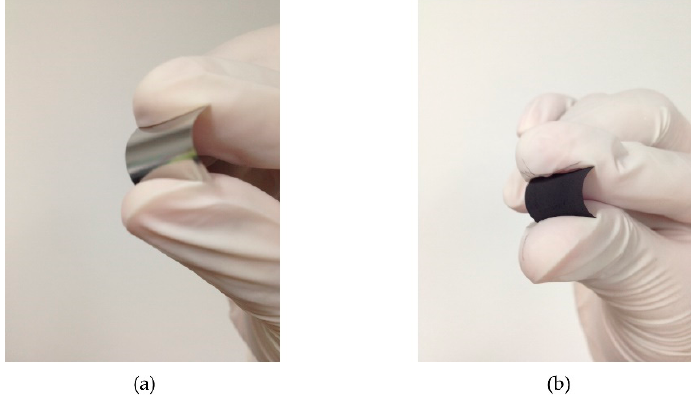
Figure 3. Photograph of 1.6 × 3.0 cm 2 304 SS foil ( a ) before and ( b ) after CVD process.